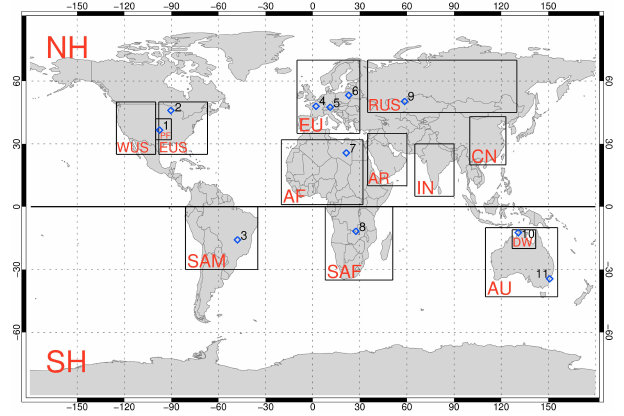
Fig. 8. Regions and locations analysed in this study (see also Ta- bles 2 and 4).